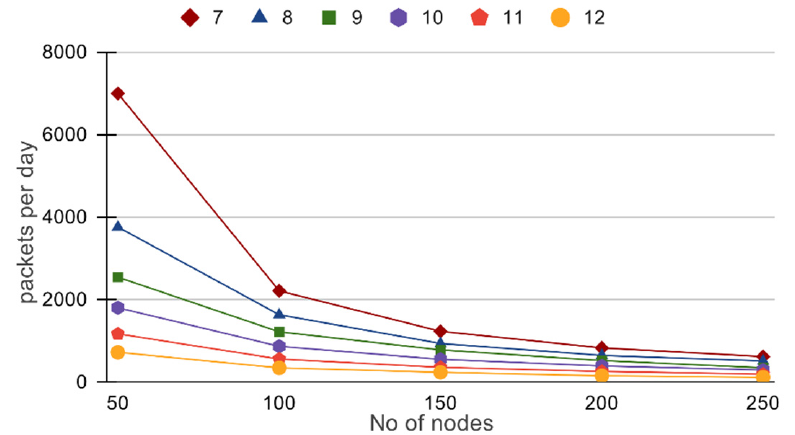
Figure 17. Packet per day versus number of nodes in different SF.